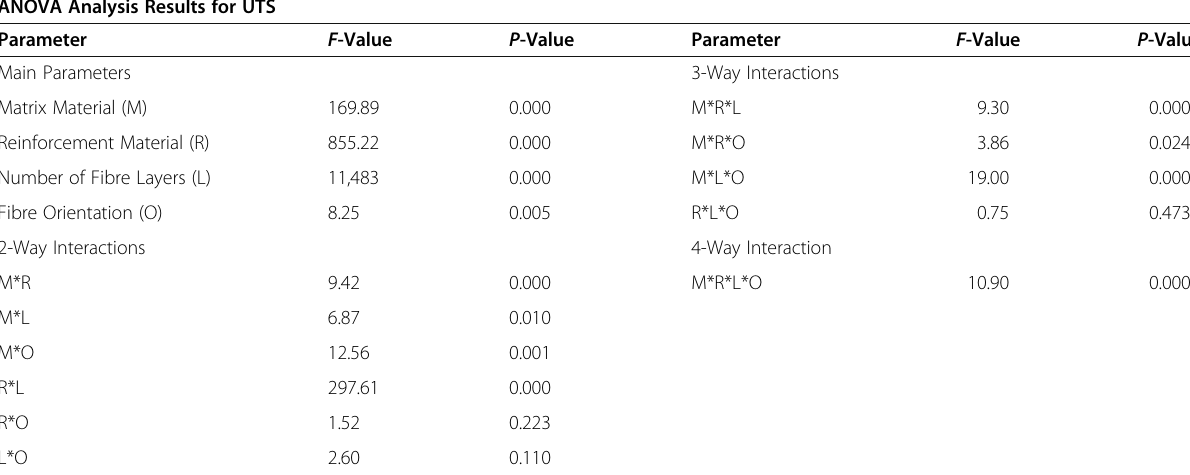
Table 4 ANOVA Results for Main Parameters and All Interactions for UTS ANOVA Analysis Results for